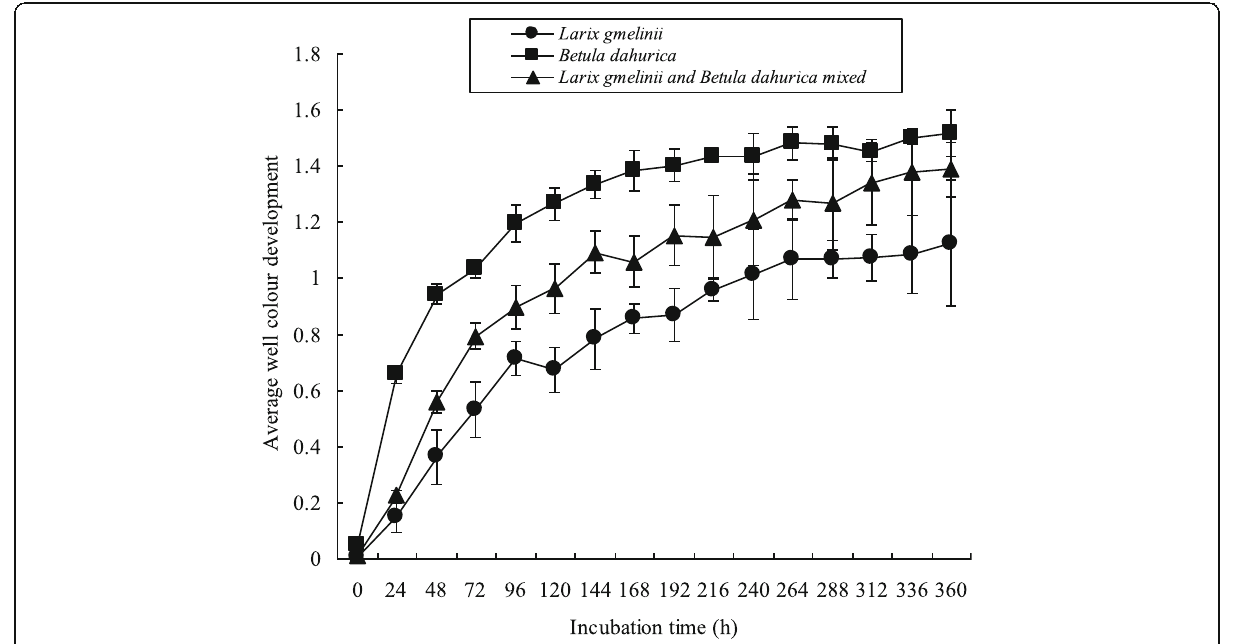
Fig. 1 Average well colour development (AWCD) of the soil community for three forest types with incubation